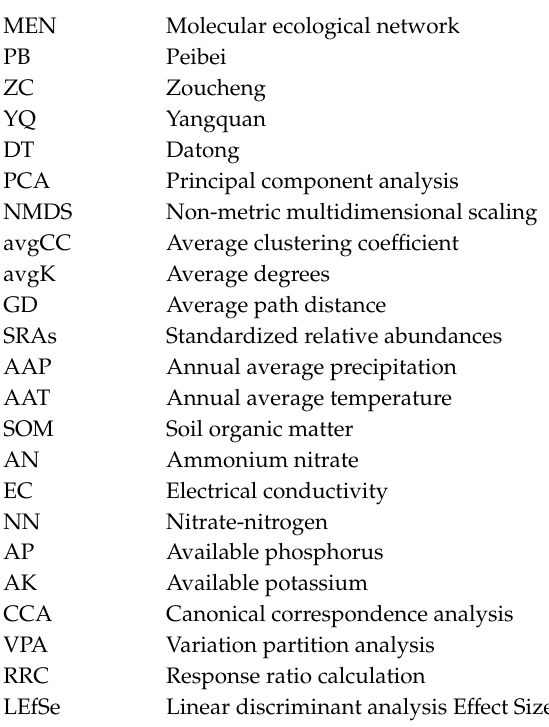
each mining area. Additional file 16: Figure S6. LEfSe analysis of soil bacterial phylogenetic composition among the four mining